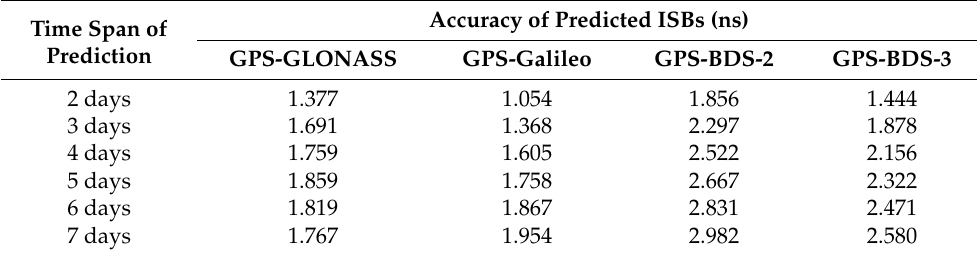
Table 2. Prediction accuracy of daily ISBs with a time span of prediction of 2–7 days.